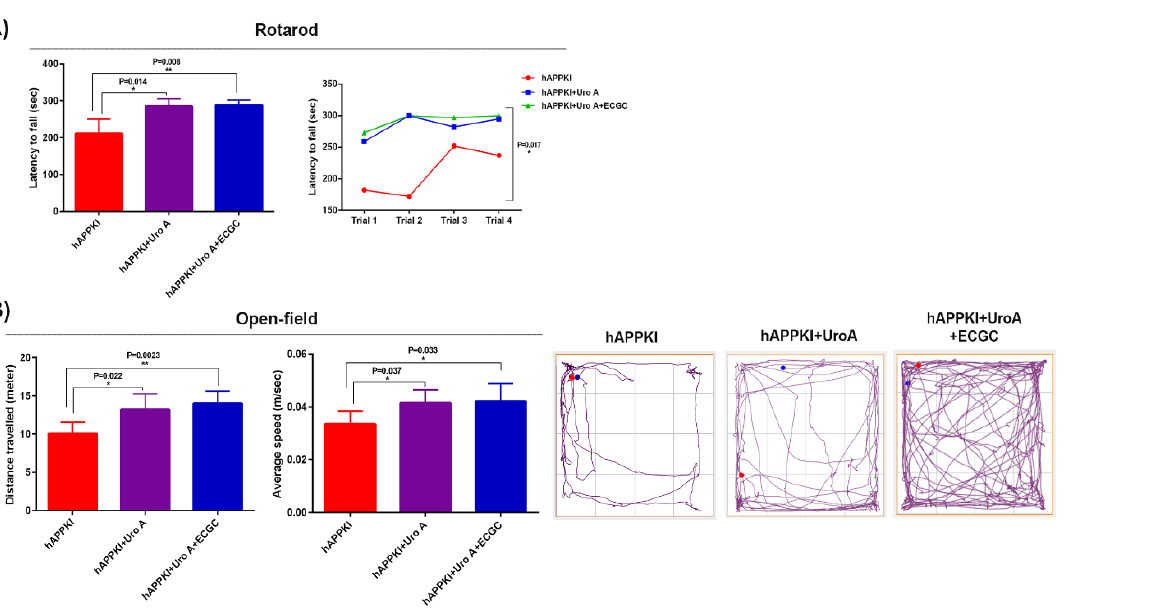
Figure 2. Cognitive behavior of seven-month-old hAbKI and hAbKI mice treated with Urolithin A and EGCG. Phenotypic behavior is evaluated using rotarod for motor coordination, open field for locomotor activity/exploration abilities, Y-maze for working memory and Morris water maze for spatial learning and memory in seven-month-old hAbKI mice and hAbKI mice treated with Uro- lithin A and EGCG. ( A ) On an accelerating rotarod test, hAbKI mice did not stay longer compared to treated mice with Urolithin A and EGCG. ( B ) In open field, hAbKI mice showed reduced total distance traveled and average speed compared to treated mice. ( C ) In the Morris water maze test, hAbKI mice showed an increased time to find the platform, and increased distance traveled com- pared with treated mice. ( D ) In the Y-Maze test the total number of arm entries was significantly reduced and the percentage of spontaneous alternation between the arms of the Y-maze was signif- icantly decreased for seven-month-old hAbKI compared treated mice.